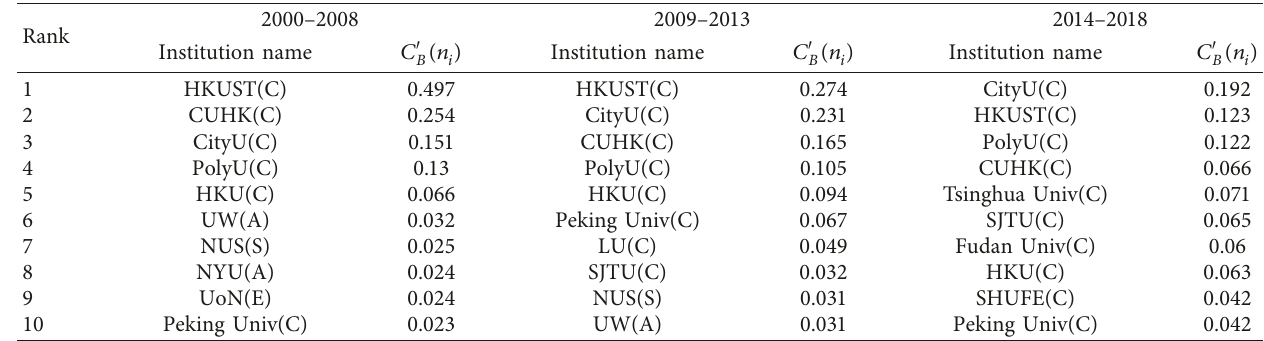
Table 7: The top ten institutions’ betweenness centrality in three stages.